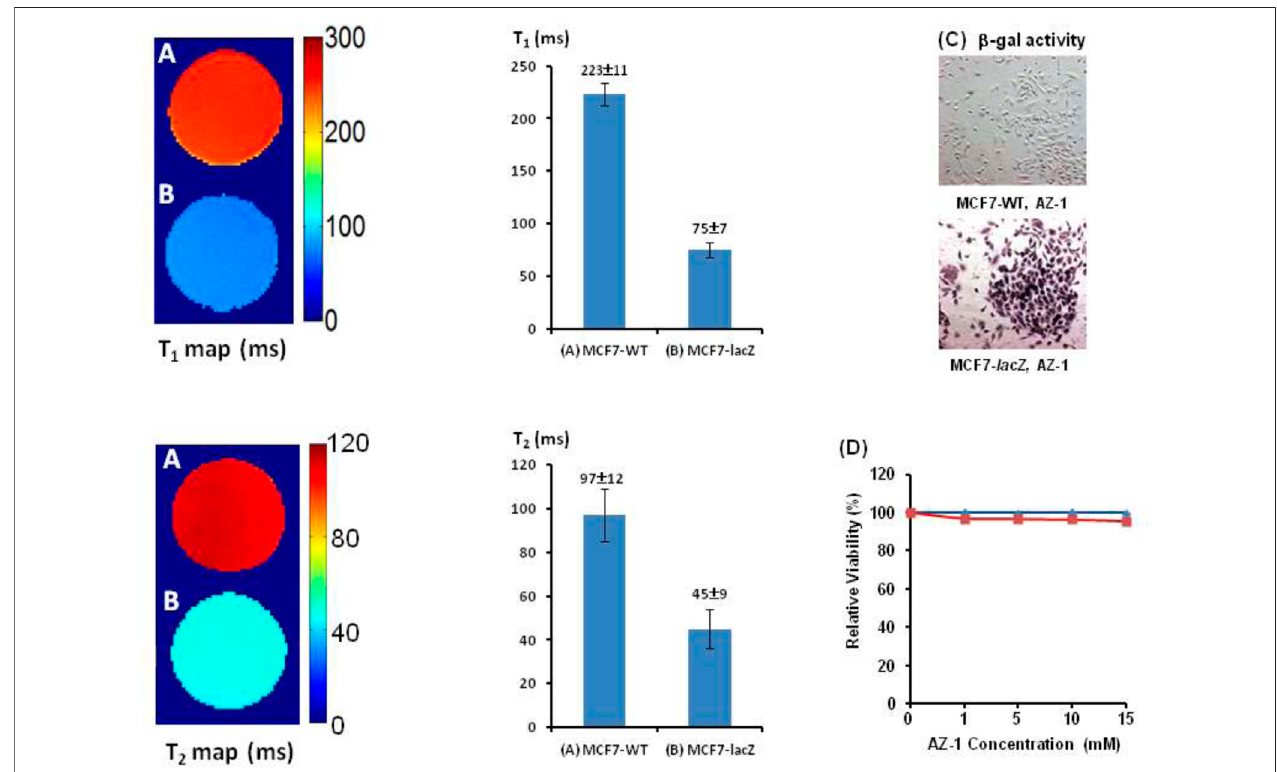
FIGURE 9 | In vitro 1 H-MRI detection of the lacZ gene expression in MCF7- lacZ cells. 1 H-MRI acquisition: using the same parameters as in Figure 2 . T 1 and T 2 Maps: Solution ofalizarin 2- O - β - D -galactopyranoside AZ-1 (10.0 mM)and FAC (10.0 mM) in1:1 (V/V ′ ) DMSO/PBS (0.1 M, pH (cid:1) 7.4) after incubation 4 h at 37 ° Cunder 5% CO 2 /air with95% humiditywith (A) MCF7-WT cells [5 × 10 5 , T 1( AZ-1/MCF7-WT/FAC ) (cid:1) 223 ± 11 ms, T 2( AZ-1/MCF7-WT/FAC ) (cid:1) 97 ± 12 ms]; (B) MCF7- lacZ cells [5 × 10 5 , T 1( AZ-1/MCF7- lacZ /FAC ) (cid:1) 75 ± 7 ms,and T 2( AZ-1/MCF7- lacZ /FAC ) (cid:1) 45 ± 9 ms]; (C) MCF7-WT/MCF7- lacZ cellsstainingby AZ-1 :darkvioletstainingcon fi rmingintense lacZ expressioninMCF7- lacZ cellswithessentiallyno β -galactivityinMCF7-WTcells.Regionalmagni fi cation × 100; (D) Cytotoxicity:MCF7-WT/MCF7- lacZ cellsviability vs. AZ-1 invariousconcentrationsin1:1(V/V ′ )DMSO/PBS(0.1 M,pH (cid:1) 7.4)at37 ° Cunder5%CO 2 /airwith95%humidityfor72 h,MCF7-WTcells(inblue),andMCF7- lacZ cells (in